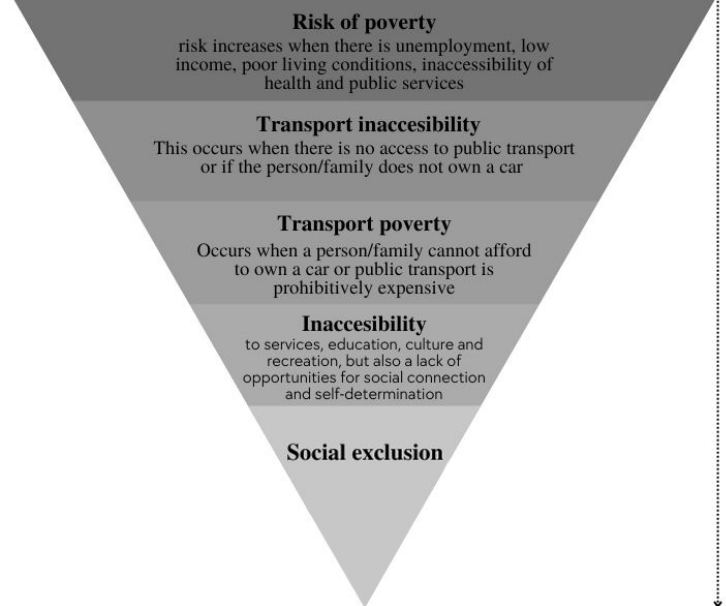
Figure 2. The relationship between a risk of social poverty, transport inaccessibility, and social ex- clusion (own study, based on [1–3,5,15,52,53]).